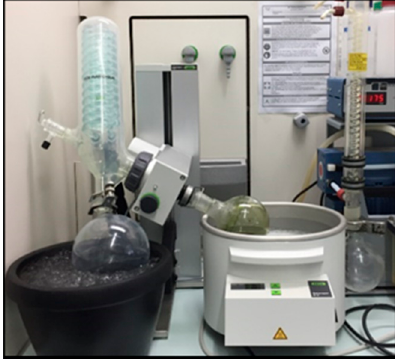
Figure 2. Evaporation of alcohol using a rotary evaporator .